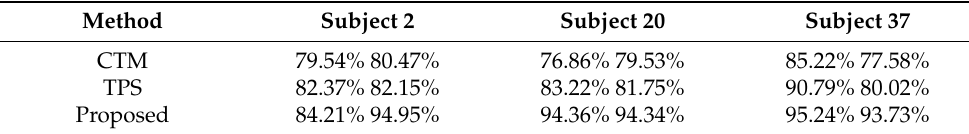
Table 1. Rat brain segmentation accuracy analyses based on κ D in Figures 5 and 6.